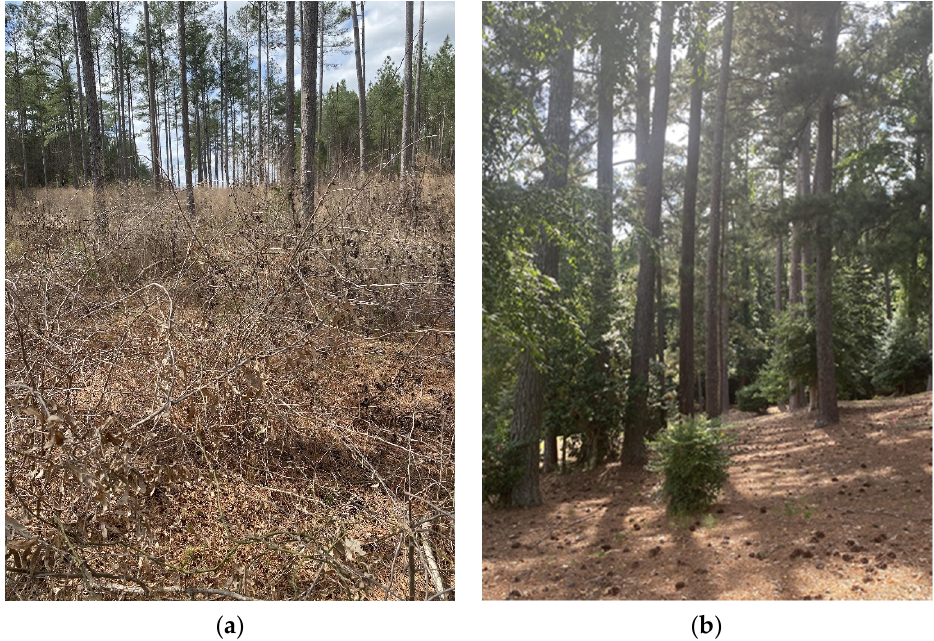
Figure 2. Sampling locations: ( a ) stand in the Clemson Experimental Forest, ( b ) urban forest stand on the Clemson University Campus. Table 1. Characteristics of the sites sampled.